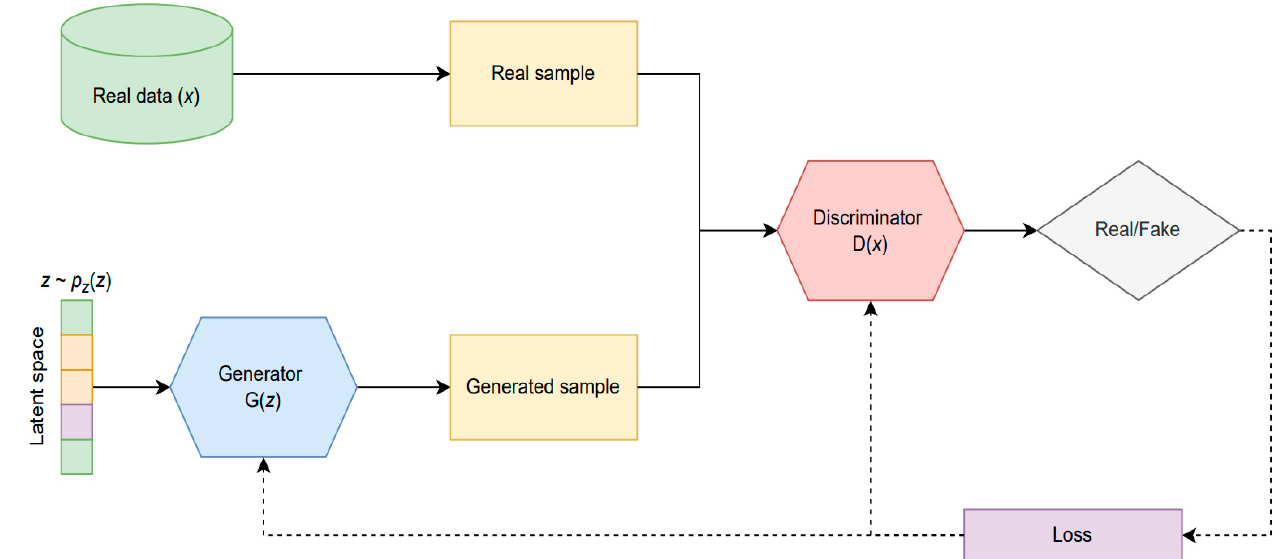
Figure 2. Generative adversarial networks scheme.